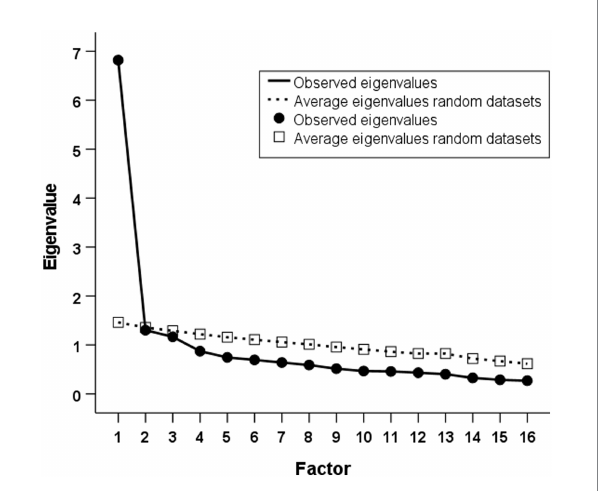
FIGURE 1 Scree plot of observed eigenvalues and average eigenvalues from parallel analysis (50 random